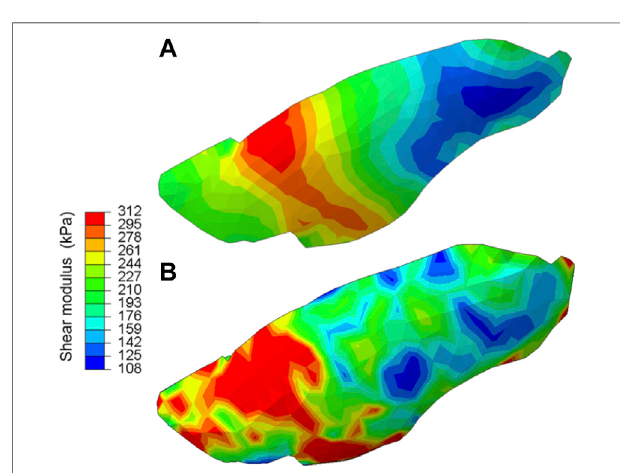
FIGURE 4 | The shear modulus map obtained for the hetero/iso/linear- elastic case obtained from (A) the gradient-based and (B) derivative-free optimization algorithms. Both methods consistently demonstrated strong heterogeneity in the tissue elasticity distribution across the lung